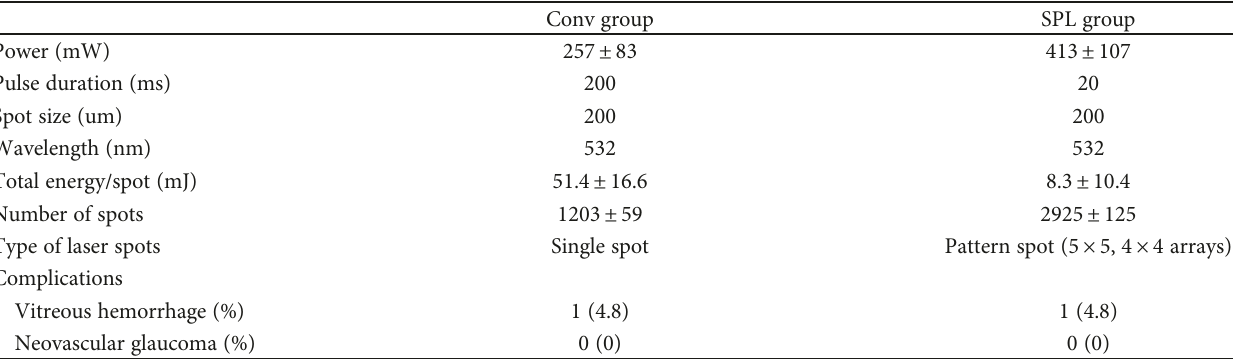
Table 3: Summary of parameters relating to lasers.